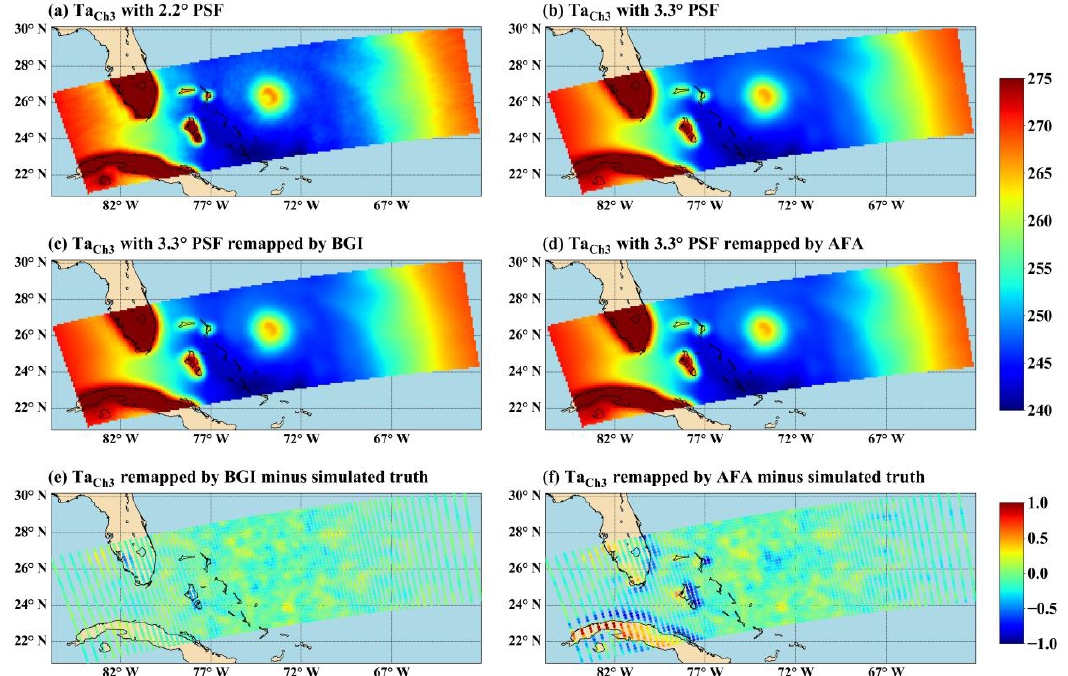
Figure 6. Simulation results of ATMS channel-3 resolution degradation from the original 2.2° FOV to the expected 3.3° FOV. Simulated ( a ) original and ( b ) expected observations; remapped observations by ( c ) the BGI and ( d ) the AFA; the difference between the remapping results of ( e ) the BGI and ( f ) the AFA and the simulated truth (remapping minus truth). Units are K.